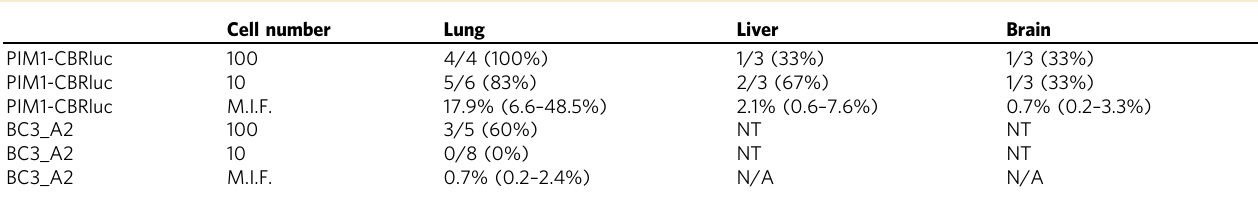
Of mice that grew MFP tumors upon transplantation of tumor cells in limiting dilutions, the frequency of metastasis was quanti fi ed with BLI ex vivo in two PDX models. The number of organs that harbored metastases is shown over the number of organs assayed by BLI, and the percent of positive organs is shown in parentheses. The estimated metastasis-initiating frequency (MIF, 95% con fi dence intervals shown in parentheses) is shown for each site NT: not tested, N/A: not applicable